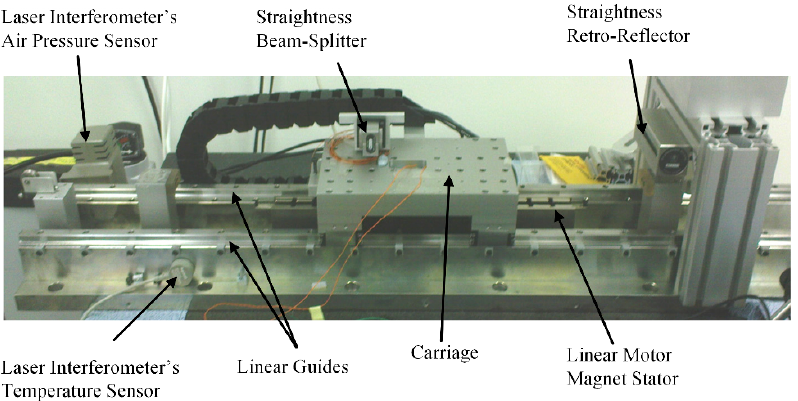
Figure 9. Assembled single-axis stage with a linear motor (LM) and roller bearings for straightness measurements. Reprinted with permission from ref. [82]. Copyright 2012 Elsevier Ltd.